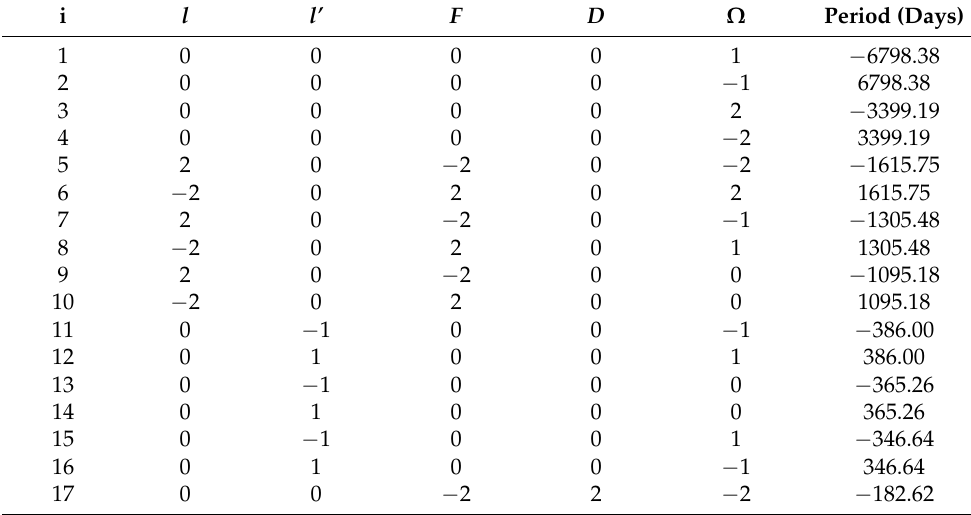
Table 1. Harmonic terms of the nutation model considered in the